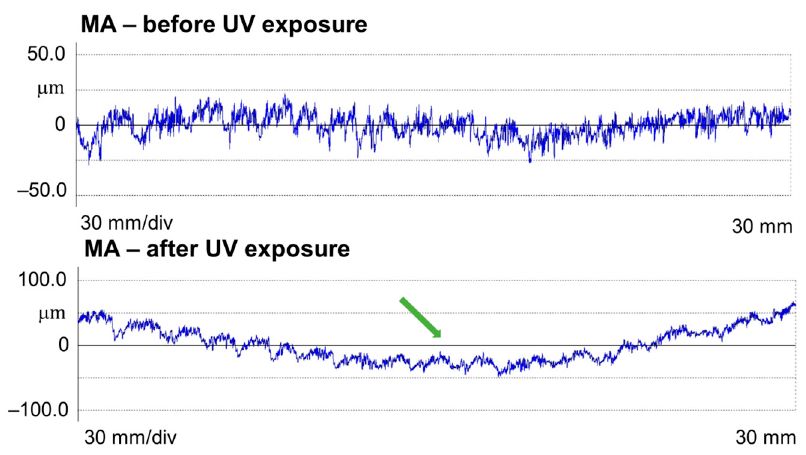
Figure 8. Measured profile of MA spruce samples before and after UV treatment (legend: the deformation/bulging of the piece is marked with the green arrow).